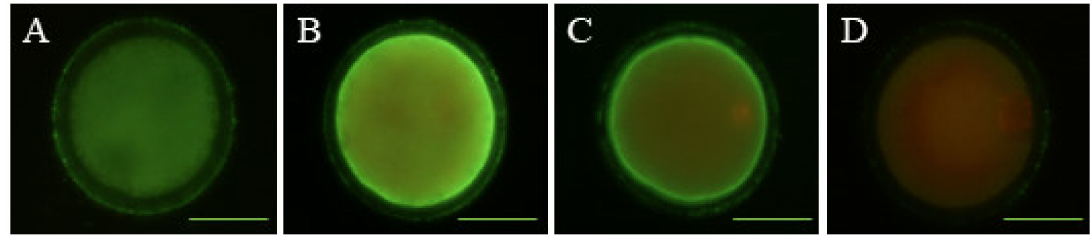
Figure 1. Representative images of early apoptosis detection in sheep oocytes. Oocytes were stained by Annexin V and PI. ( A ) Viable oocytes; ( B ) early apoptotic oocytes; ( C , D ) non-viable oocytes. Scale bar = 52 µ